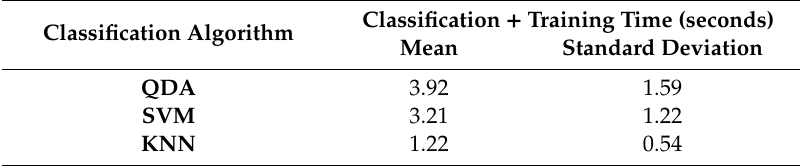
Table 5. Mean and standard deviation of training and classification times (seconds) for each classification algorithm across each study site and feature set combination with ten trials per